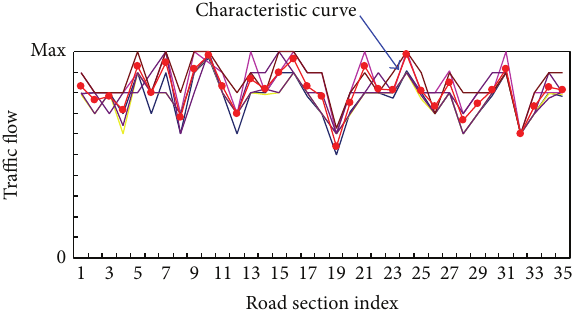
Figure 3: The characteristic curve of traffic state mode.